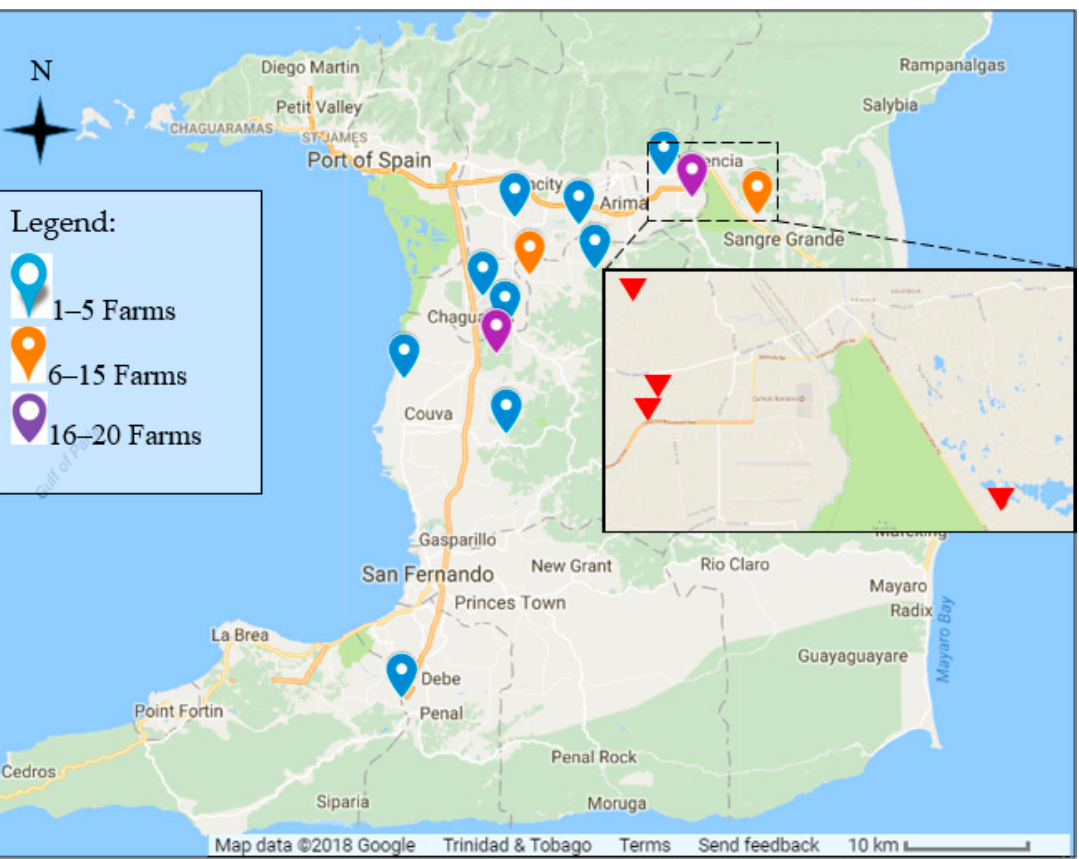
Figure 1. Map of Trinidad and Trinidad (10.6918° N, 61.2225° W) showing locations of dairy farms where bulk milk samples were collected. Inset: Wallerfield-Turure area showing locations of the four farms where individual milk samples were taken.